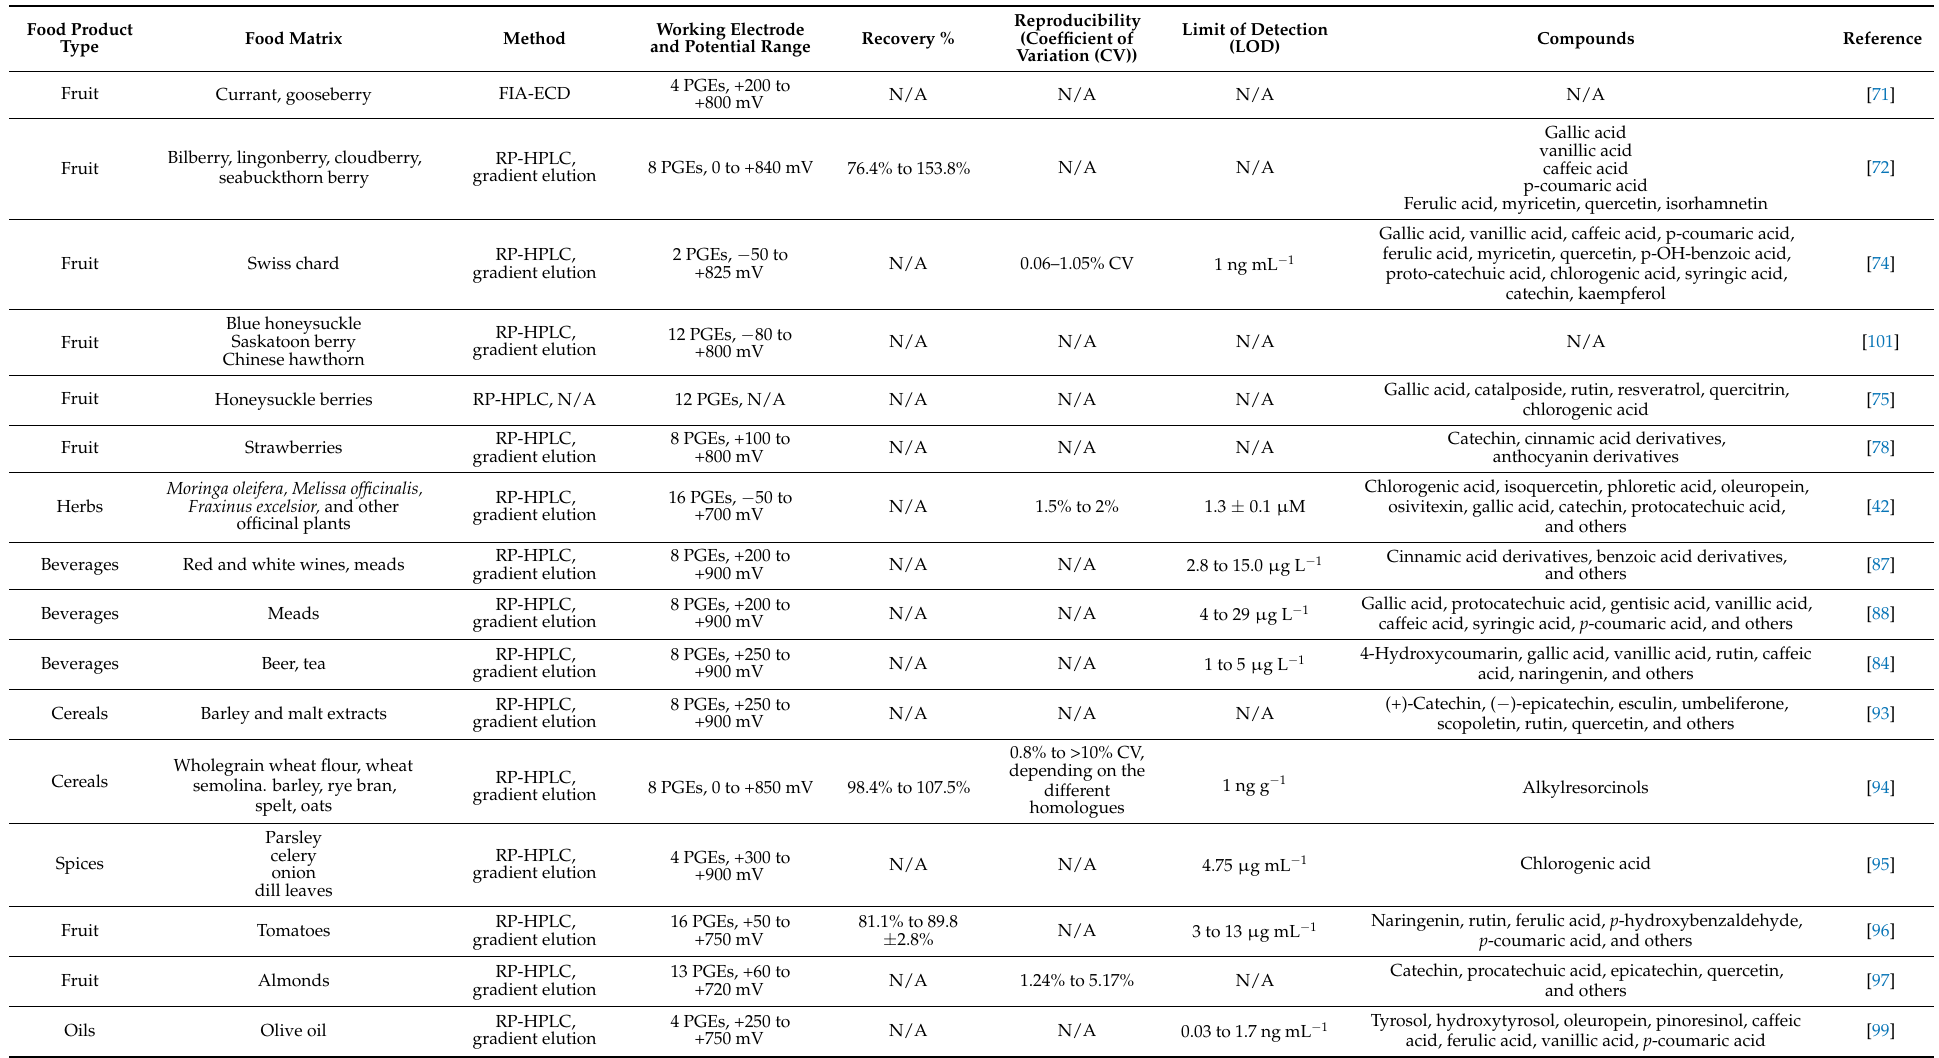
Table 1. Examples of phenolic compounds detected in food and beverages by the coulometric array